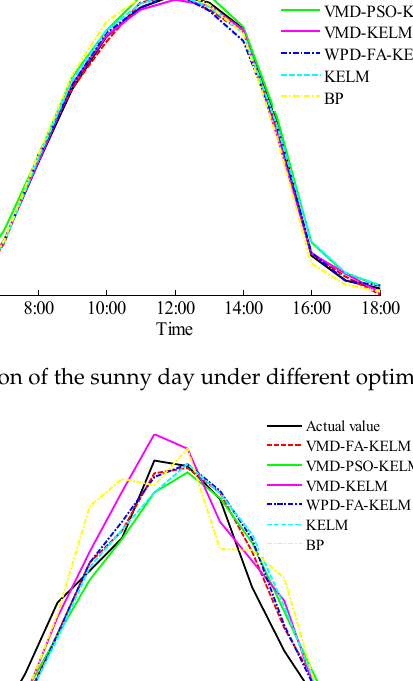
Table 7. Point prediction indices of different optimization algorithms. Model